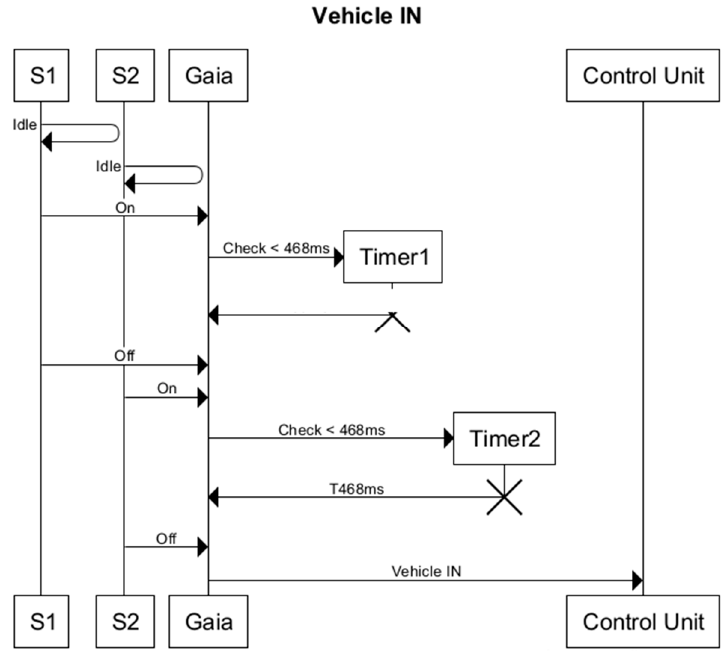
Figure 8. Vehicle entry detection sequence diagram.